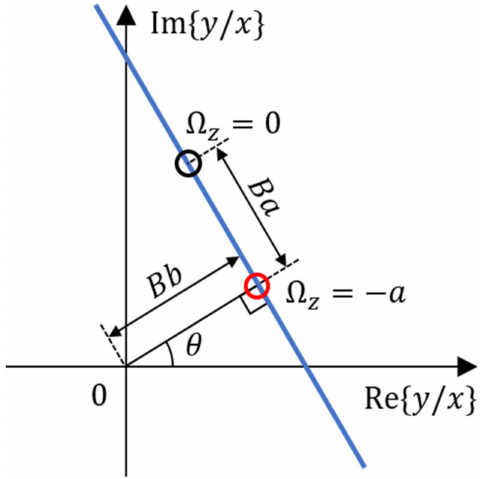
Figure 4. Analysis of the y/x trace for an asymmetric resonator. The y/x ratios collected with various angular rates form a straight line in a complex plane. The plot shows that the distance from the origin to the nearest point on the line is Bb , and the angular rate giving the nearest point is − a , and the distance from the nearest point to the Ω z = 0 point, along the line, is Ba